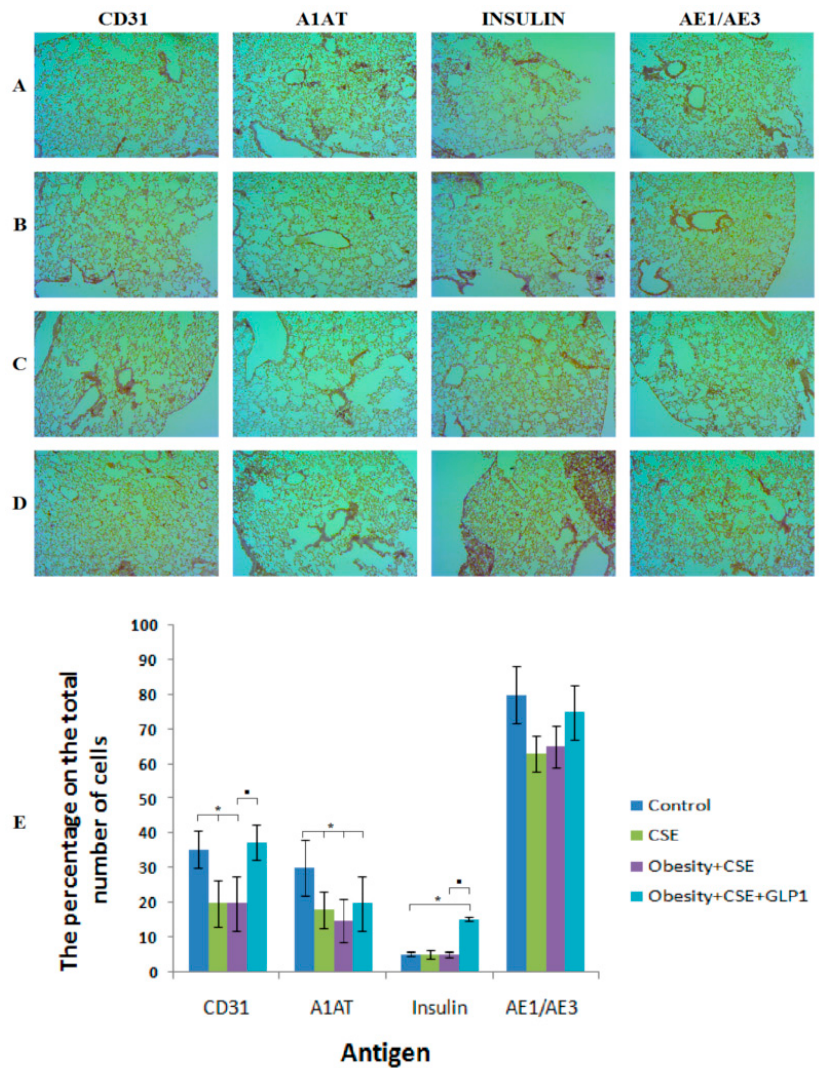
Figure 4. Immunohistochemical staining for specific cellular markers: CD31, α 1-antitrypsin (A1AT), insulin, pan-cytokeratin (AE1/AE3) in the lungs from female C57BL/6 mice (brown stain). ( A ) Control group; ( B ) CSE; ( C ) Obesity + CSE; ( D ) Obesity + CSE + GLP-1. ( E ) The relative content of cells expressing specific antigens in all groups. * p < 0.05 significance of difference compared with control group, ■ p < 0.05 significance of difference compared with the obesity + CSE group.